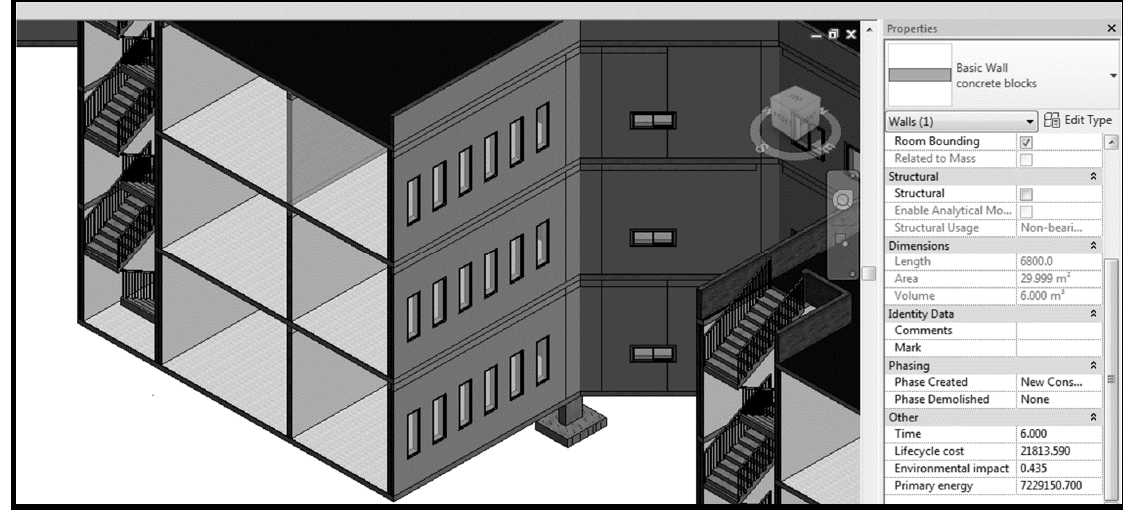
Fig. 8. Sample section of wall